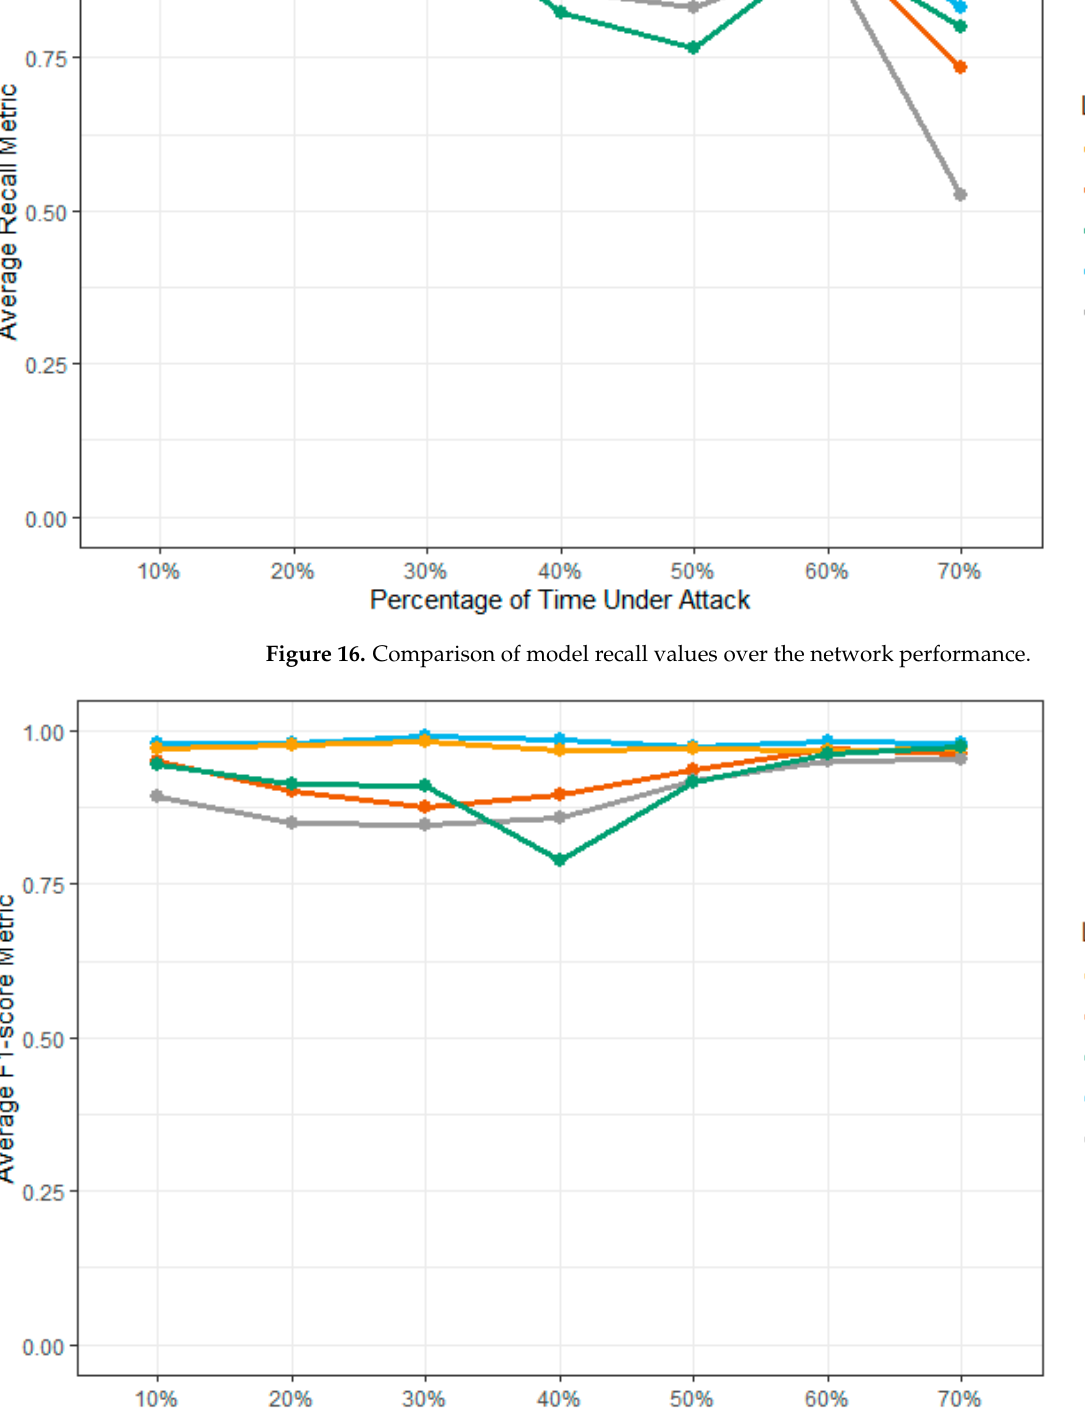
Table 7. Model F-1 results under different networks.